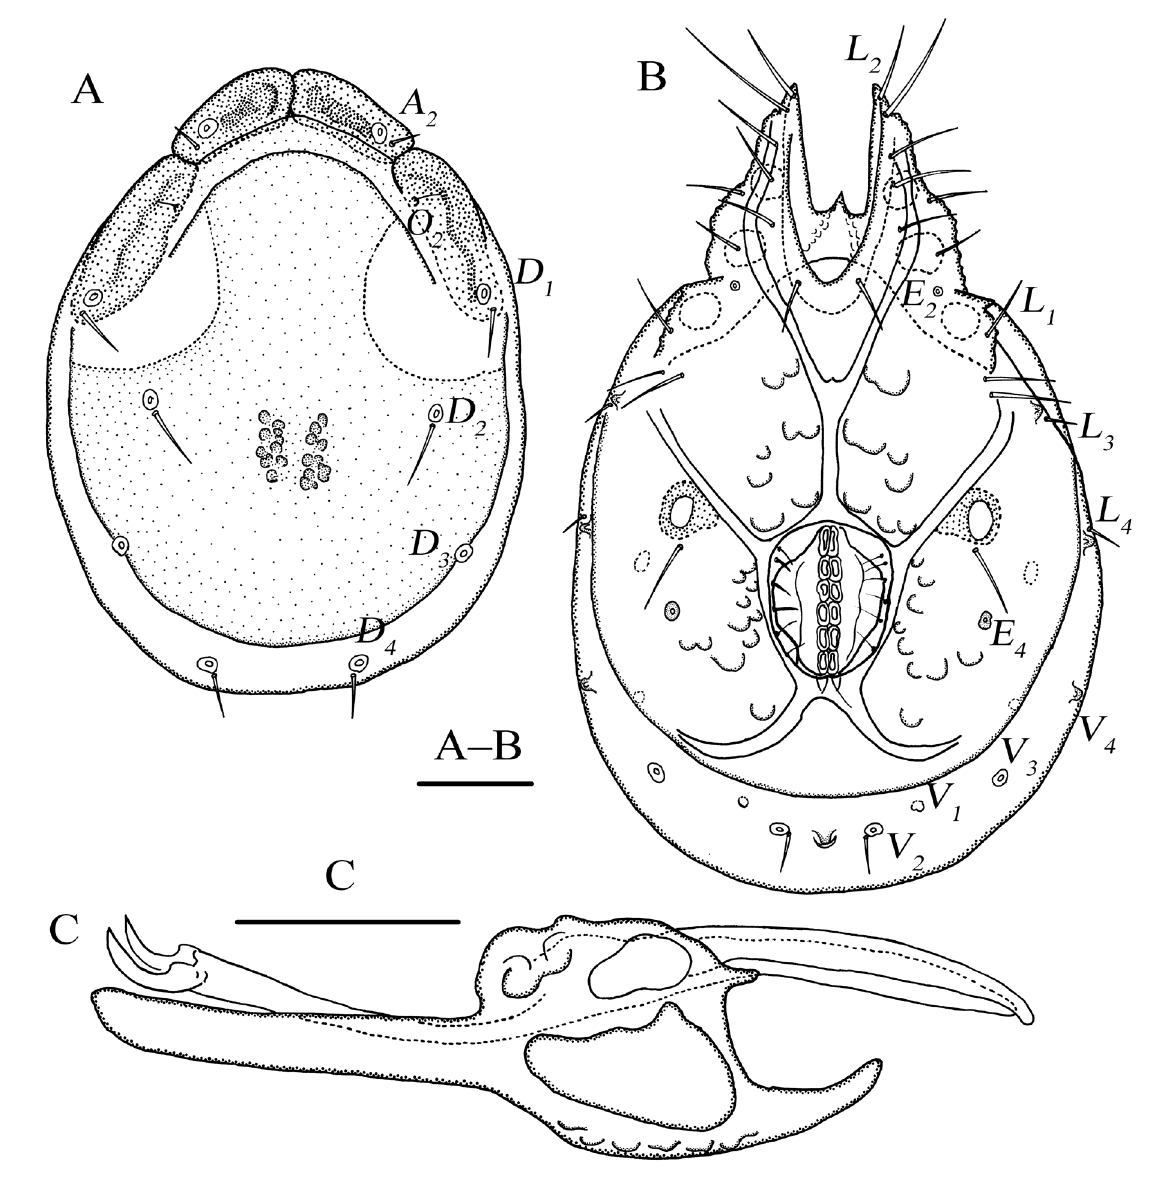
Fig. 3. Torrenticola suptilisrostrum Gu & Guo sp. nov., ♀, paratype ( FJ-TO-20180803) . A . Dorsal view. B . Ventral view. C . Infracapitulum and chelicera. Scale bars = 100